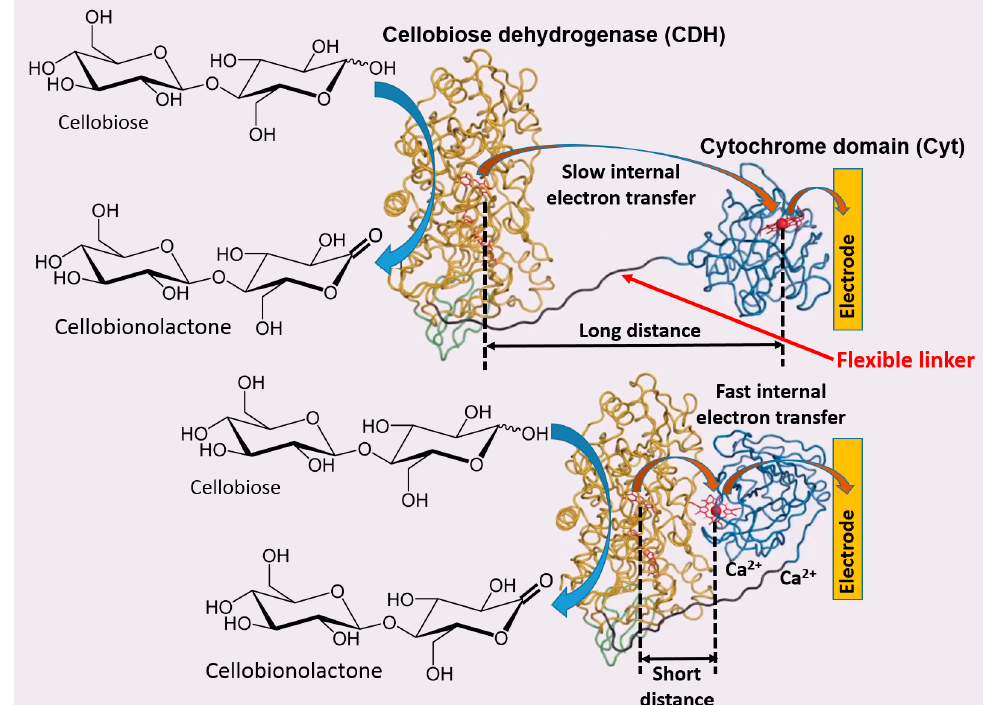
Figure 6. Direct electron transfer from the immobilized cellobiose dehydrogenase (CDH) catalytic domain to an electrode via a covalently linked cytochrome (Cyt) domain. The bioelectrocatalytic current depends on the conformation of the flexible linker. The short electron transfer path resulting in facilitation of the current was realized in the presence of Ca 2+ cations.